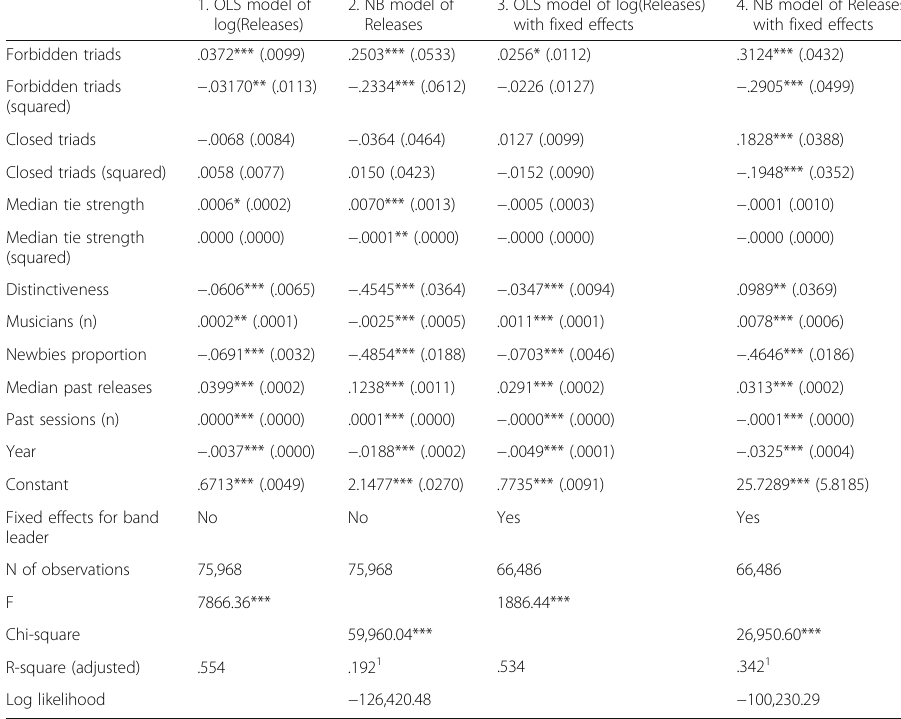
Table 9 Statistical models of success, with National Endowment for the Arts Jazz Masters award winning band leaders